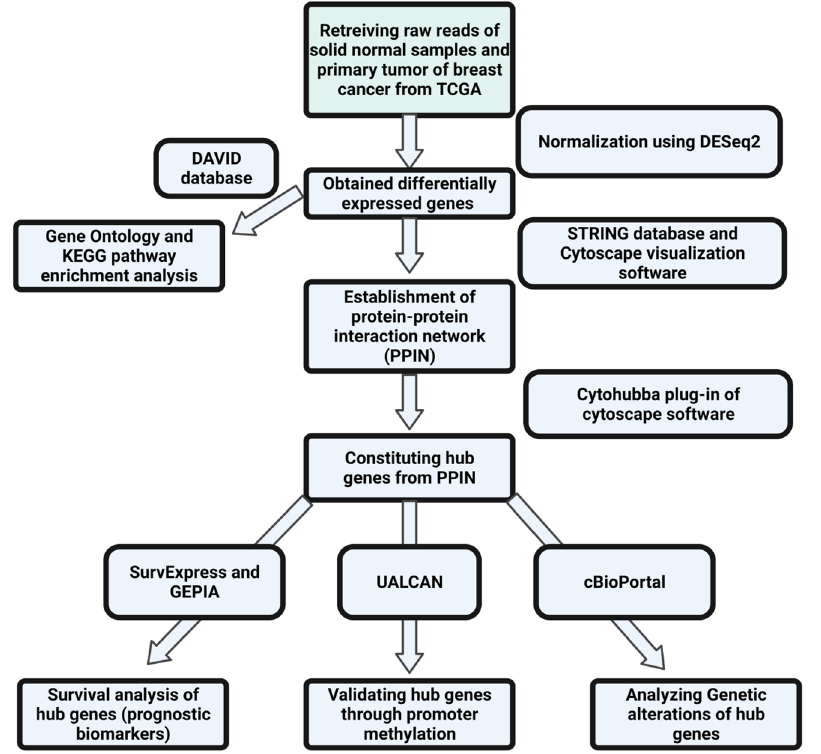
Figure 1. Flowchart showing the methodology followed in the present study.